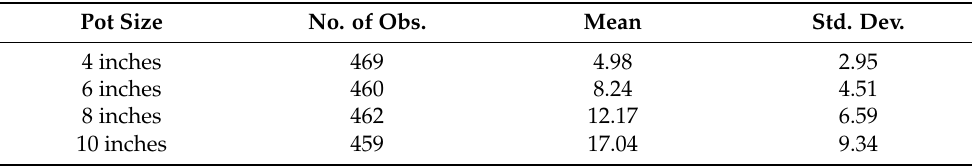
Table 7. Willingness to pay for pink poinsettia “Maren” in pot size. Pot Size No. of Obs. Mean Std.